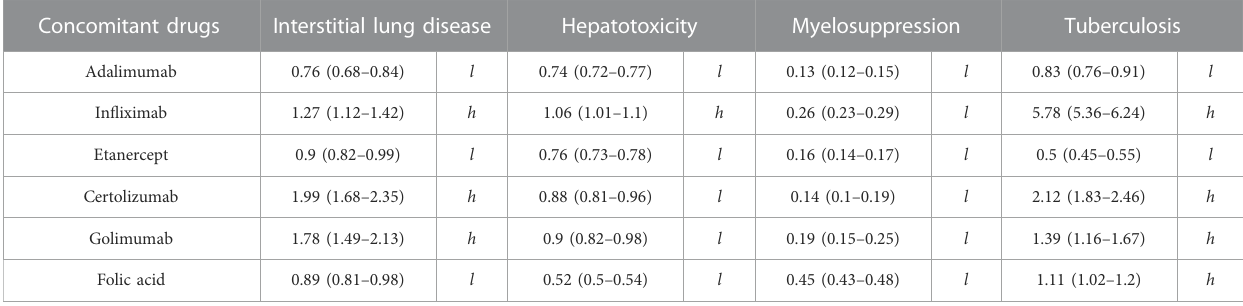
TABLE 2 Crude RORs (95% CI) for MTX – related adverse events in cases that used MTX and concomitant